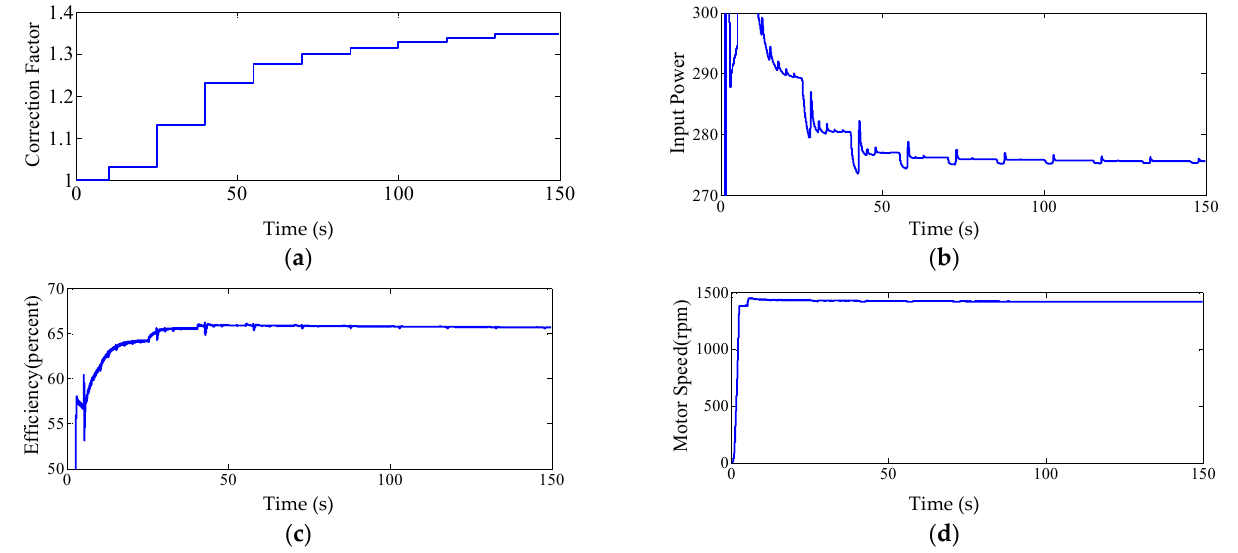
Figure 10. Tracking the optimum point ( a ) correction factor, ( b ) input power, ( c ) efficiency, ( d ) motor speed,